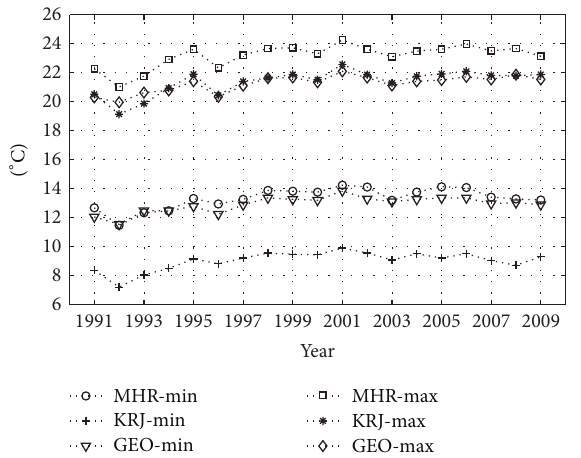
Figure 4: The annual mean, maximum, and minimum dry-bulb 2 m temperatures of stations GEO, MHR and KRJ during the period 1991–2009.